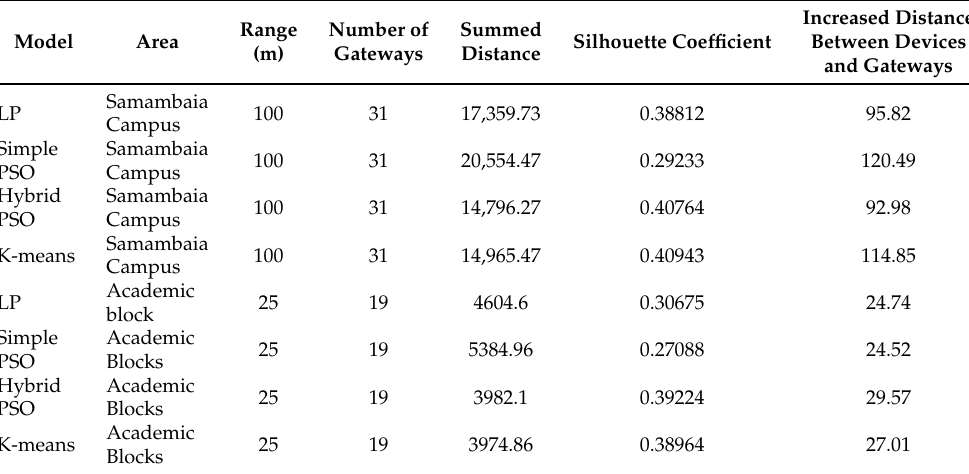
Table 15. The distance summations and silhouette coefficients of the experiments that were performed in the three scenarios, considering 300 devices and Wi-Fi communication